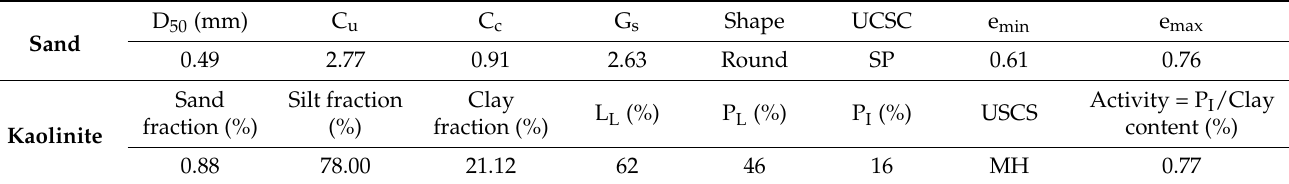
Figure 1. Gradation analysis of sand and kaolinite silt. Table 1. Geotechnical properties of the used soils.